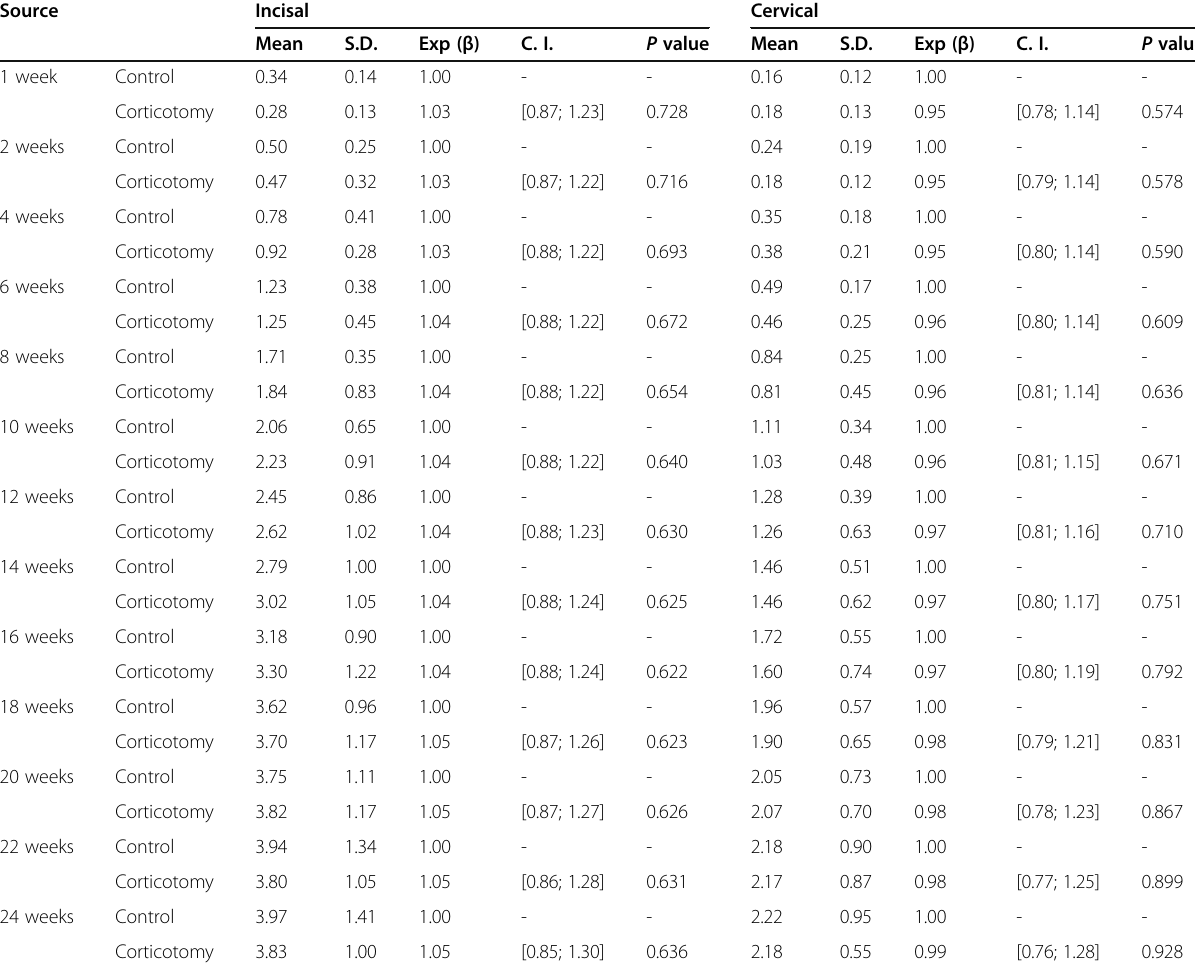
Table 2 Comparison of incisal and cervical accumulative moved distances (mm) between sides over time - group 1